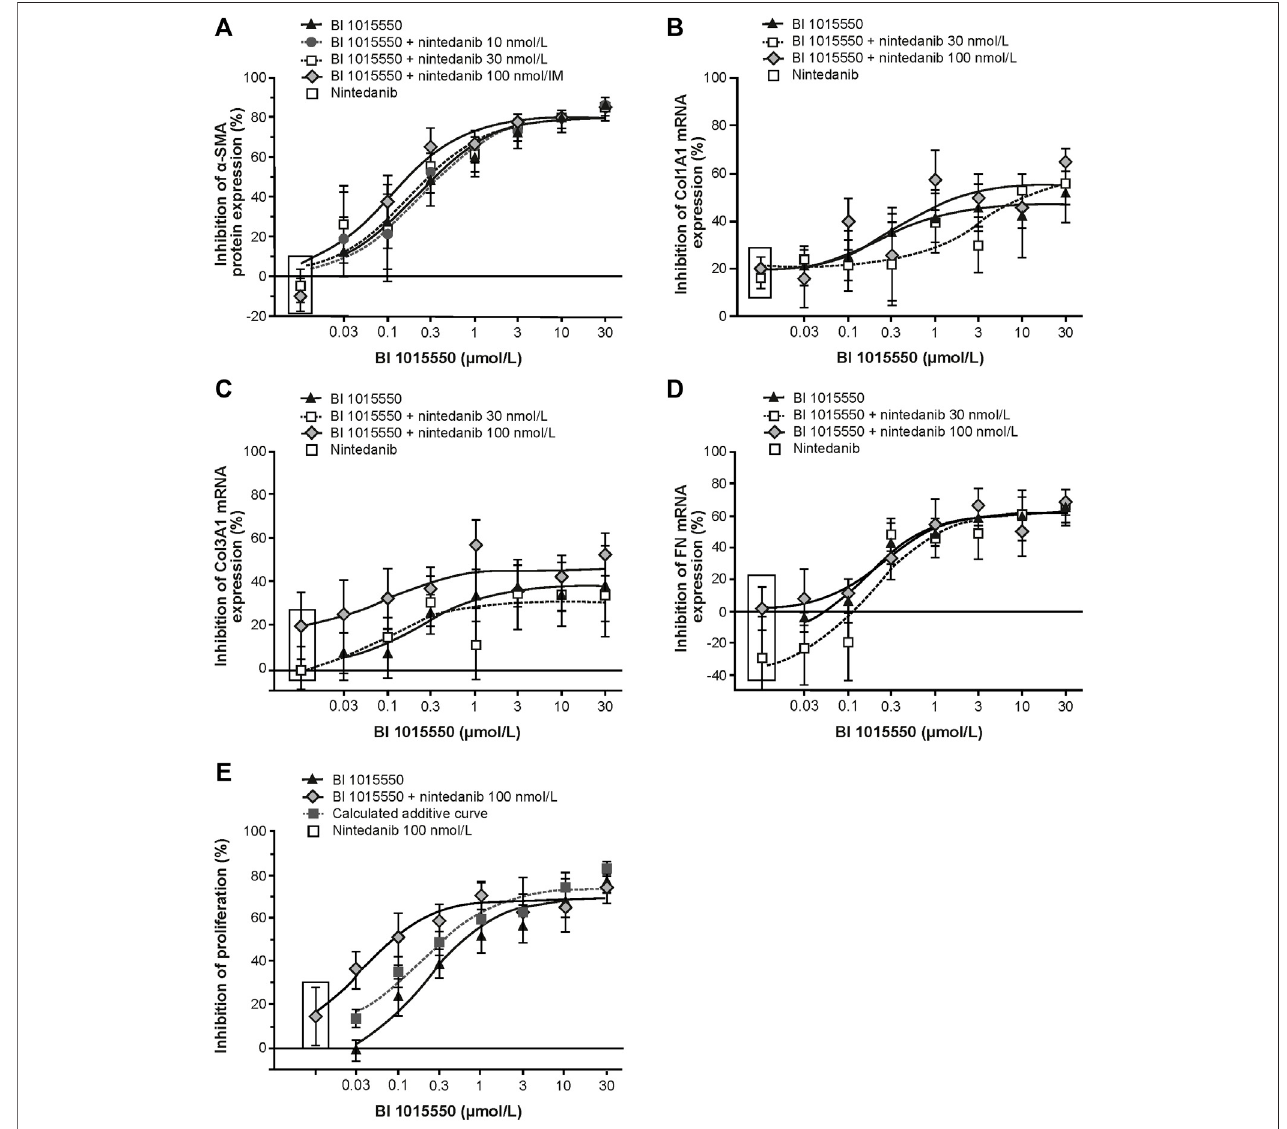
FIGURE 6 | Inhibition of primary lung fi broblasts from patients with IPF by BI 1015550. (A) TGF-ß-stimulated transformation into myo fi broblasts ( n = 6); TGF-ß- stimulatedmRNAexpression ofCol1A1 (B) ,Col3A1 (C) ,and FN (D) ( n =6,each); (E) IL-1ß plusFGF-induced proliferation( n =5).Fibroblasts fromdonorswithIPFwere pre-incubated with different concentrations of BI 1015550 plus/minus different concentrations of nintedanib and/or 1 nmol/L PGE 2 . Results are given as means ± SEM from the number of donors indicated. α -SMA, α -smooth muscle actin; Col, collagen type; FGF, fi broblast growth factor; FN, fi bronectin; IL-1ß, interleukin-1ß; IPF, idiopathic pulmonary fi brosis; PGE 2 , prostaglandin E 2 ; SEM, standard error of the mean; TGF-ß, transforming growth